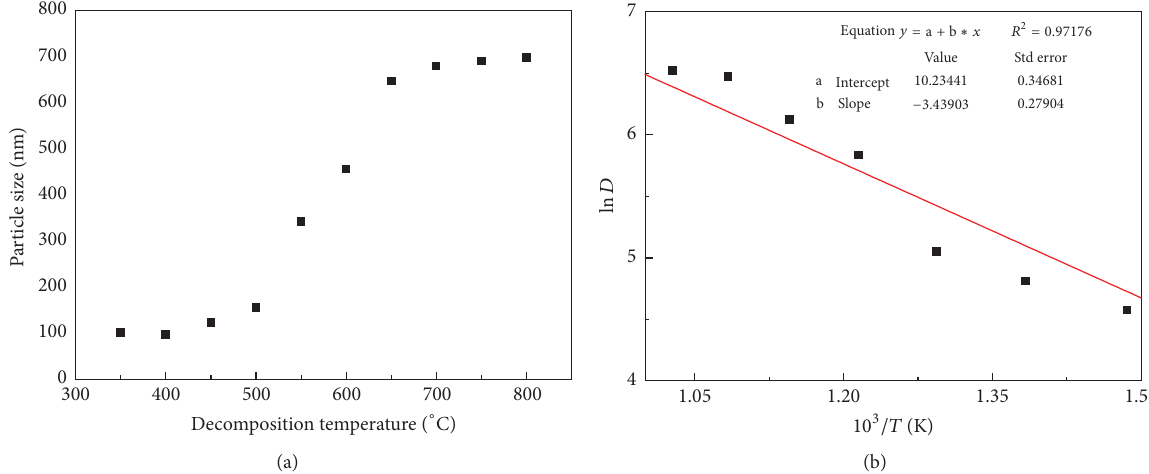
Figure 11: (a) Average particle size of Co sample (a) as a function of temperature; (b) relationship between ln (𝐷) and 10 3 /𝑇